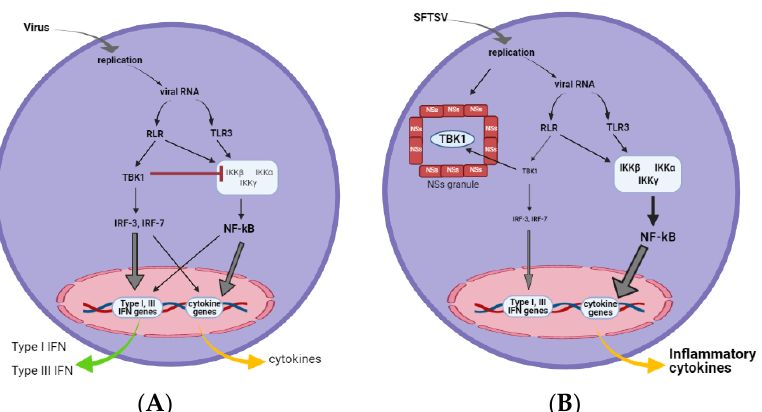
Figure 2. NSs induction of an NF- κ B-mediated cytokine storm. ( A ) In virus-infected cells, viral RNA sensing activates TBK1, which activates IRF-3 for the transcriptional activation of type I IFN and cytokine genes. TBK1 negatively regulates the IKK complex by interacting with IKK β to limit the inflammatory responses mediated by NF- κ B. ( B ) Upon SFTSV infection, viral NSs granules sequester TBK1, resulting in impaired IFN production. This liberates IKK from the negative regulation of TBK1, leading to the hyper-activation of NF- κ B and inflammatory responses.